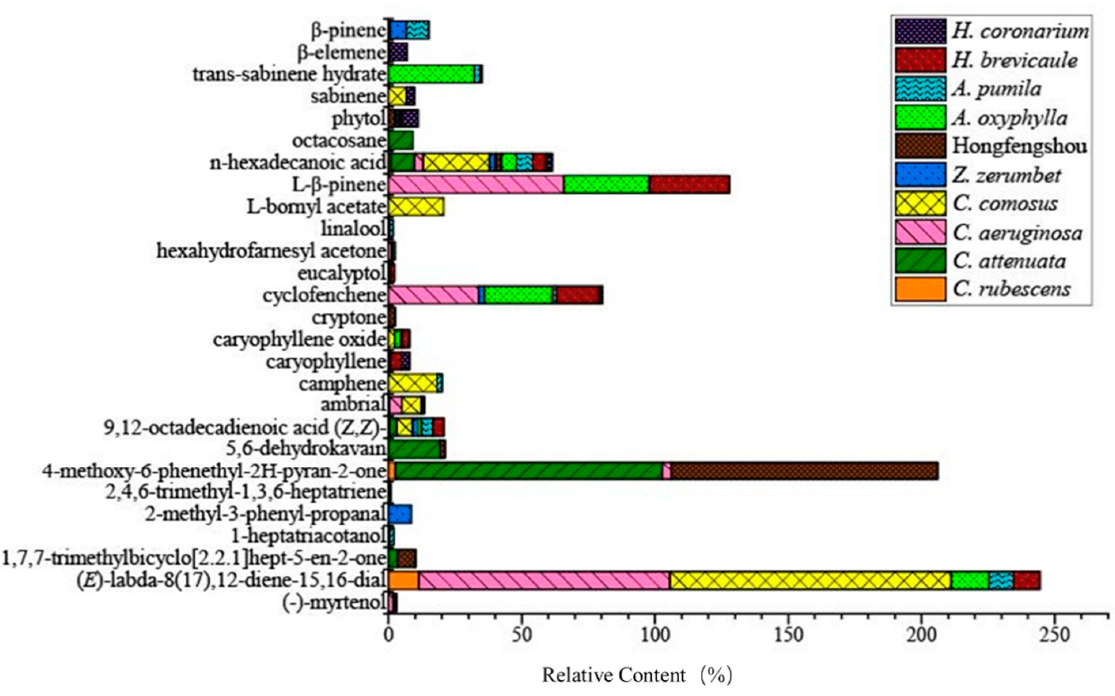
Figure 3. Relative contents of common volatiles in different Zingiberaceae plants. Different color blocks represent different plants. The size of the color block area represents the relative content.